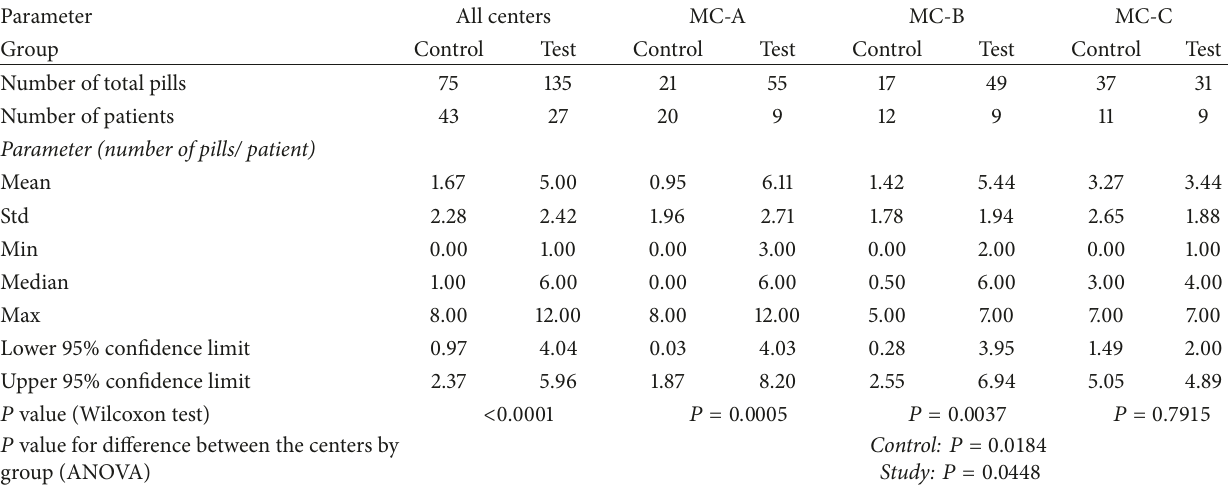
Table 4: Analysis of total pills administered by group. Analysis was done by nonparametric Wilcoxon-Mann–Whitney. Analysis of variance (ANOVA model) was applied for analyzing the difference in the study outcomes between study centers within study groups (MC: Medical